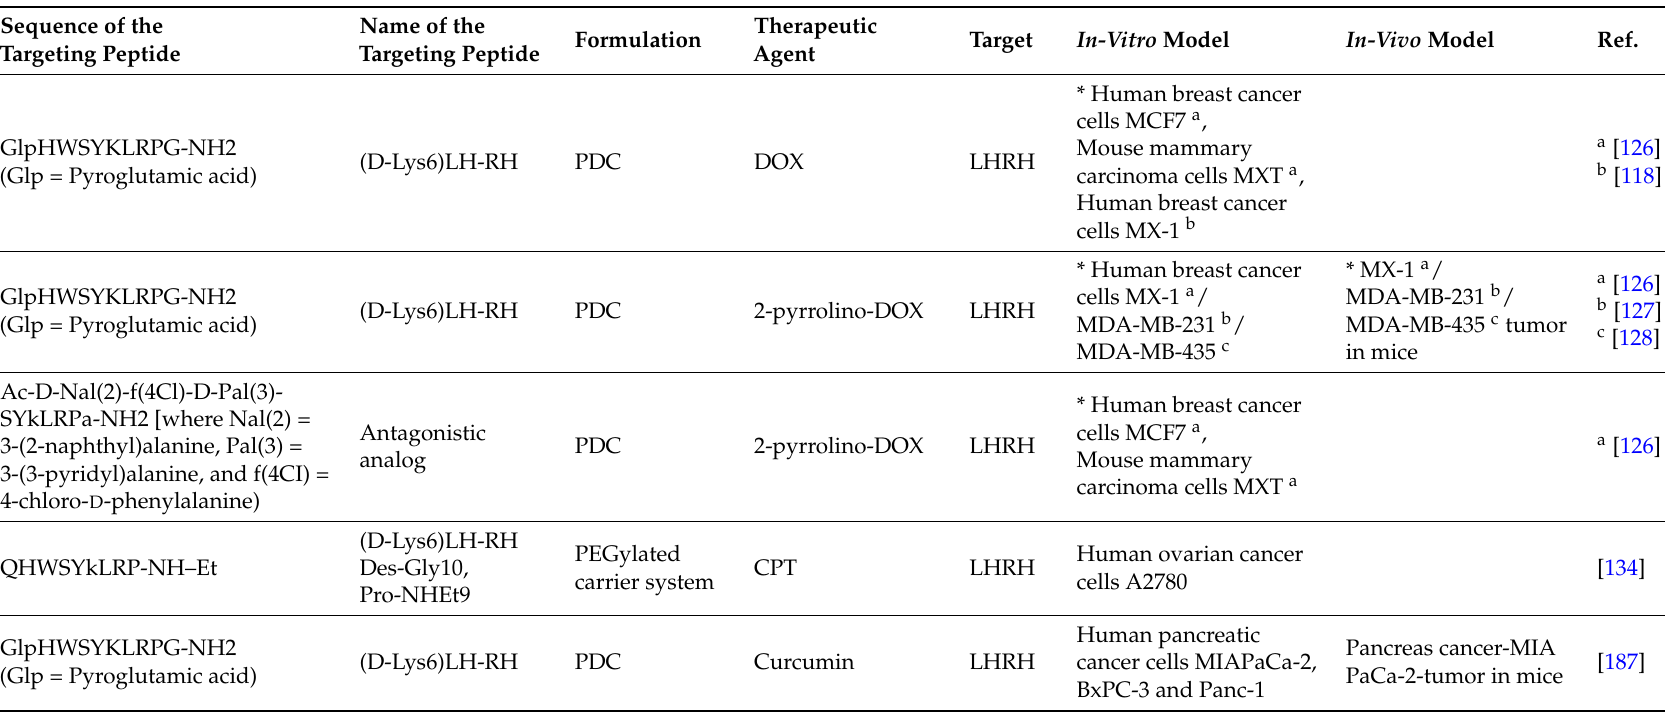
Table 1. Luteinizing Hormone-Releasing Hormone (LHRH) cytotoxic analogs.* For additional biological models of these conjugates see [2,154,186]. Sequence of